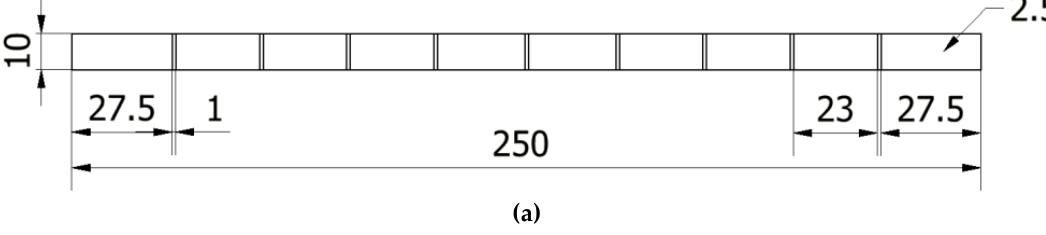
Figure 21. Testing apparatus for performing self-heating-based vibrothermography (SHVT) tests.